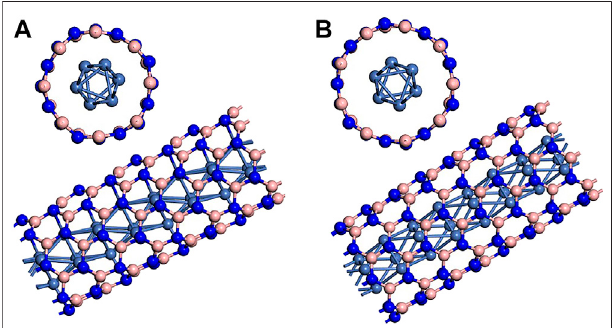
FIGURE 1 | Ni nanowire encapsulated (A) (8.0) BNNT and (B) (9.0) BNNT. The pink spheres represent B atoms, the blue spheres represent N atoms, and the light blue spheres represent Ni